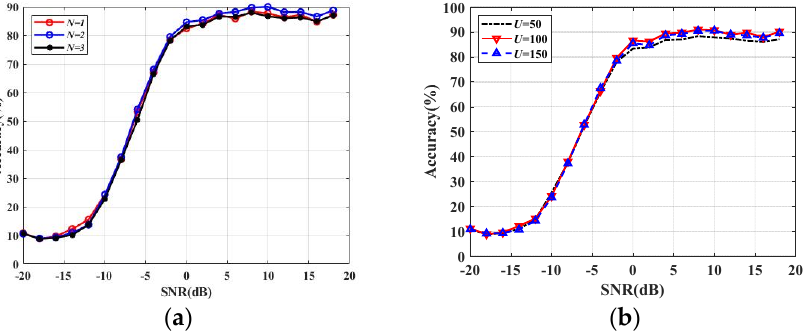
Figure 4. Classification accuracy comparison of HMF-I with varying number of ( a ) CNN layers ( N ) and ( b ) LSTM cells ( U ).